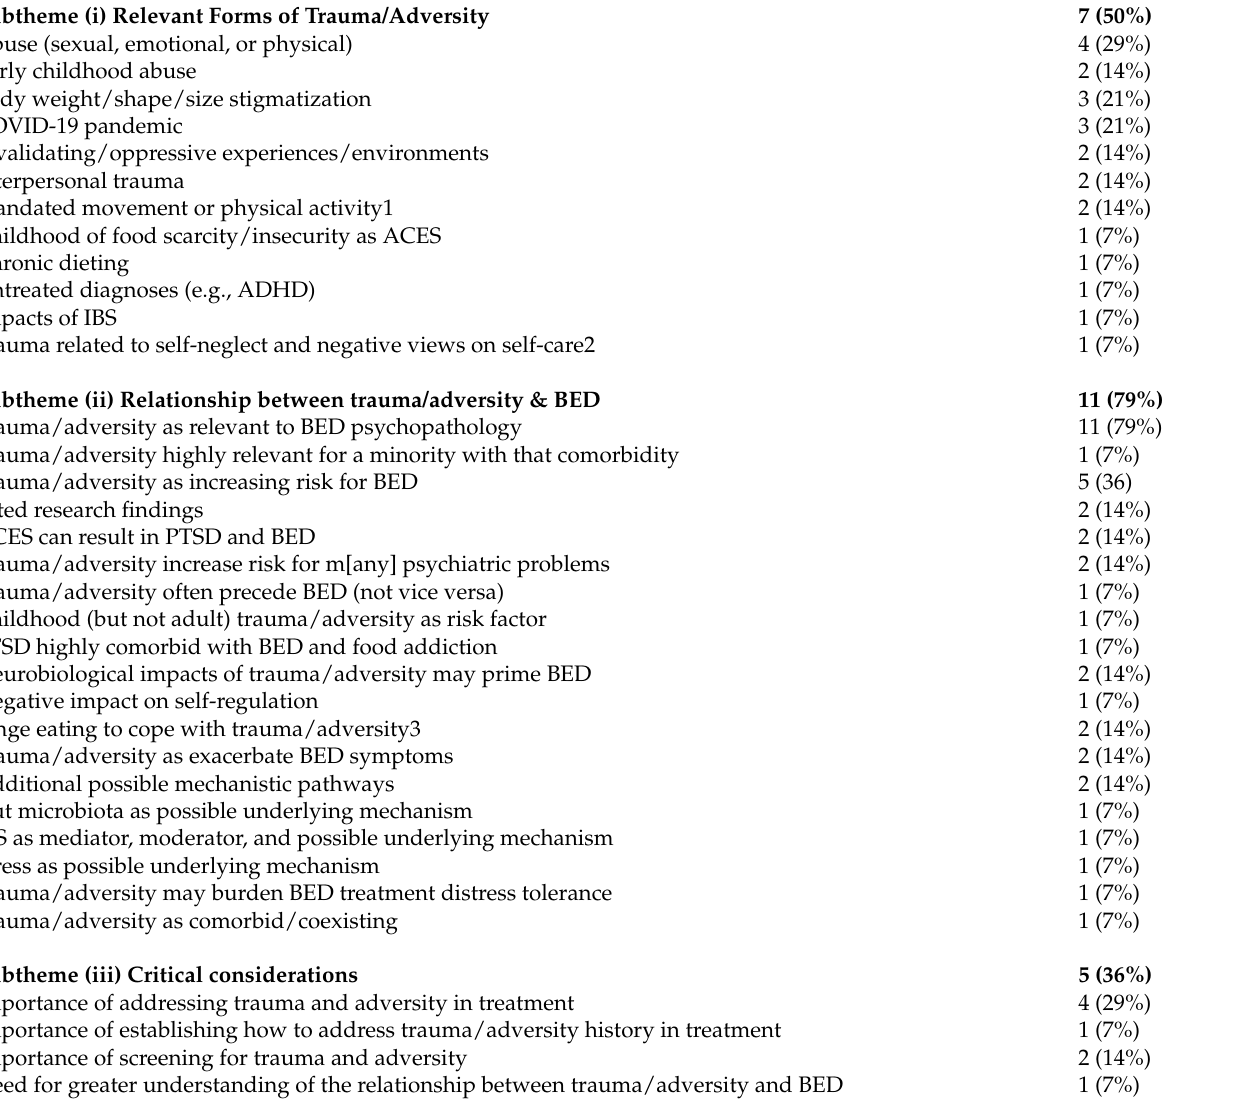
Table 8. Participant statements consistent with Theme 5, “trauma and